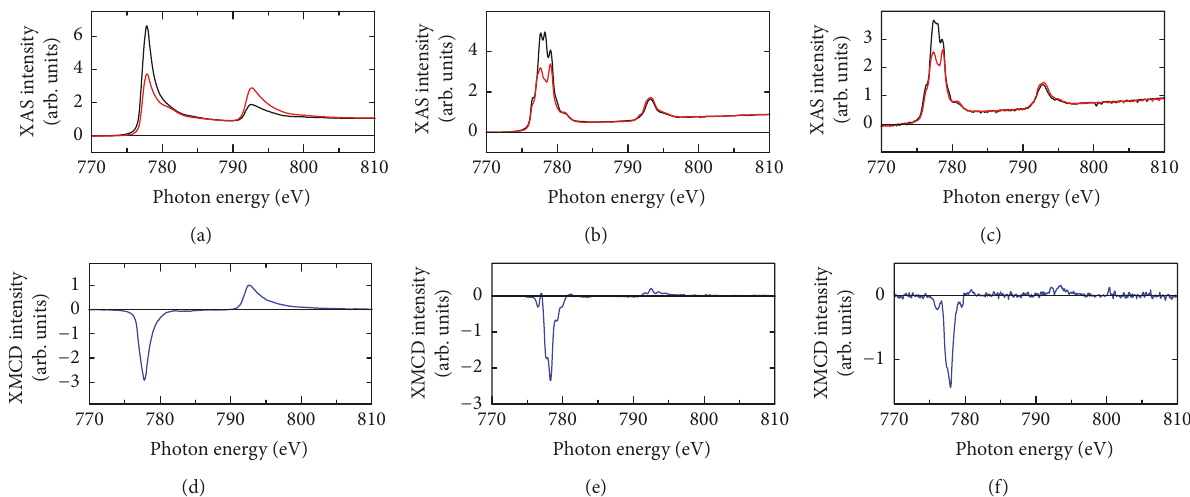
Figure 4: TEY XAS spectra taken with 𝜌 + (black line) and 𝜌 − (red line) X-rays for (a) Co metal, (b) as-deposited Co-doped ITO, and (c) annealed Co-doped ITO at 2K in an applied field of 4 T. Corresponding XMCD spectra for (d) Co metal, (e) as-deposited Co-doped ITO, and (f) annealed Co-doped ITO.